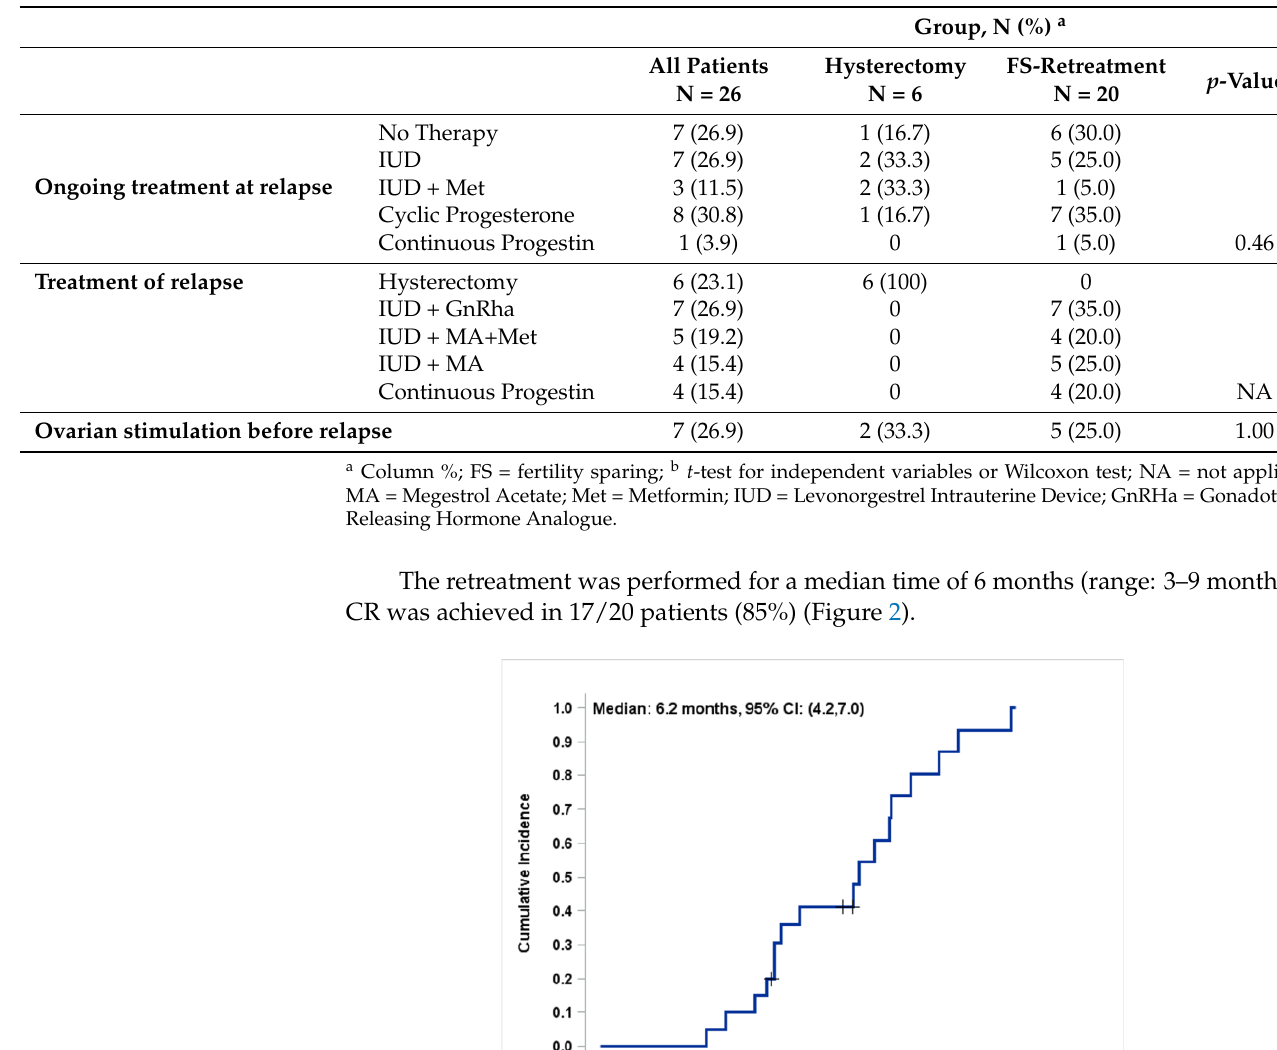
Table 2. Ongoing treatment at relapse and treatment of relapse; statistics for the groups hysterectomy and FS-retreatment.